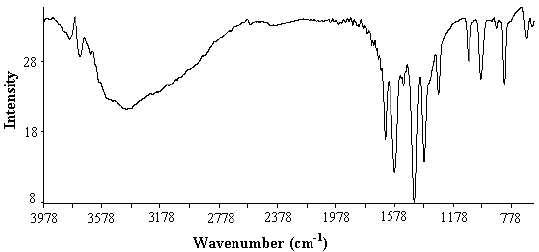
Figure 2. IR spectrum of complex 1, KBr discs, T = 298 K, vertical scale, transmission